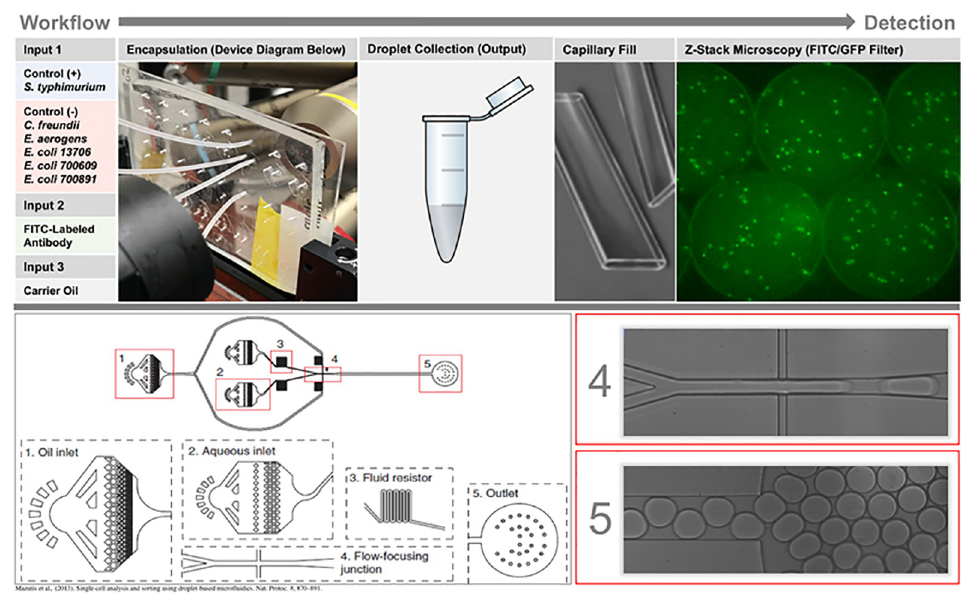
Fig 1. Workflow diagram highlighting inputs, output, sample preparation, and fluorescence procedure. A previously published diagram is utilized paired with real-time, high-speed photography of droplet formation (4) and collection at output (5).